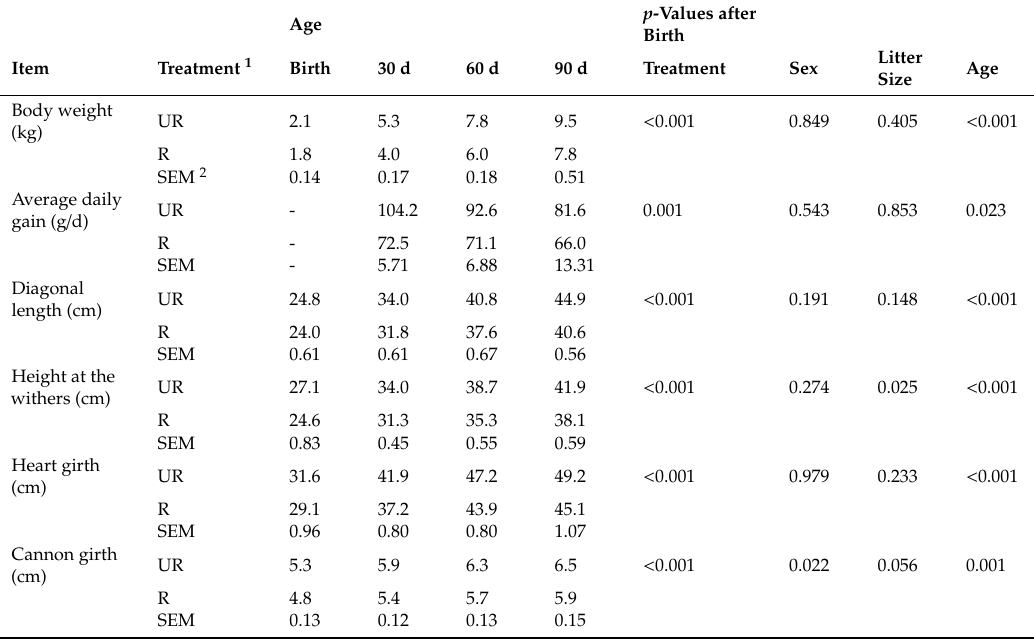
Table 4. E ff ects of maternal undernutrition during mid-gestation on the growth performance of the kids. p -Values after Age